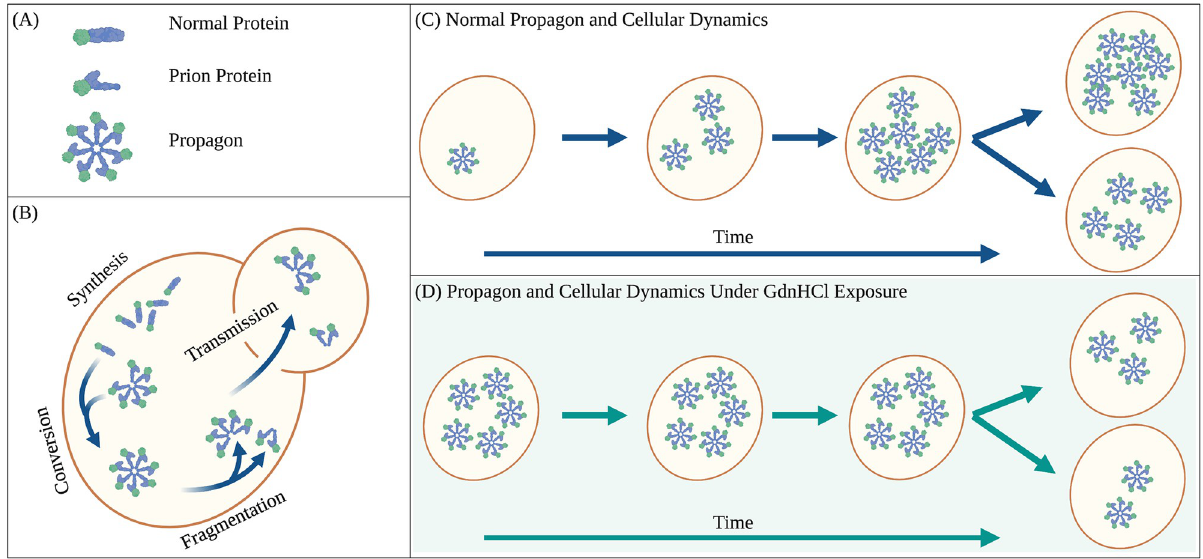
Fig 1. Multiscale yeast prion aggregate (propagon) dynamics. (A) Within each cell in the colony is a mixture of normal protein and prion (alternatively folded) protein. Prion proteins are contained in propagons of multiple alternatively folded monomers. (B) Within each cell normal protein is produced (synthesis) and incorporated into existing propagons which leads to conversion of the normal protein to the prion form and increases the size of a propagon. Aggregates may increase in number by fragmentation and must be spread from mother to daughter cells during division (transmission). (C) Under normal growth conditions, the number of propagons increases during the lifetime of a cell and is split during cell division. (D) When cells are grown under GdnHCl fragmentation is assumed to stop and the number of propagons remains unchanged during the lifetime of a